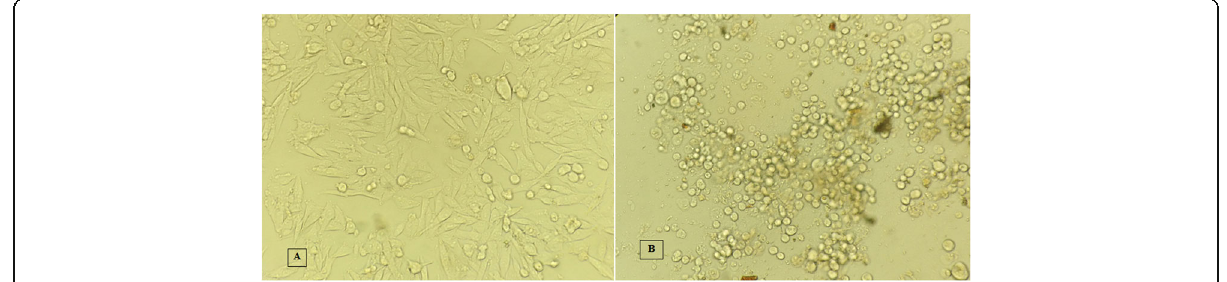
Fig. 4 LNCaP Cell lines. a Untreated. b Treated with